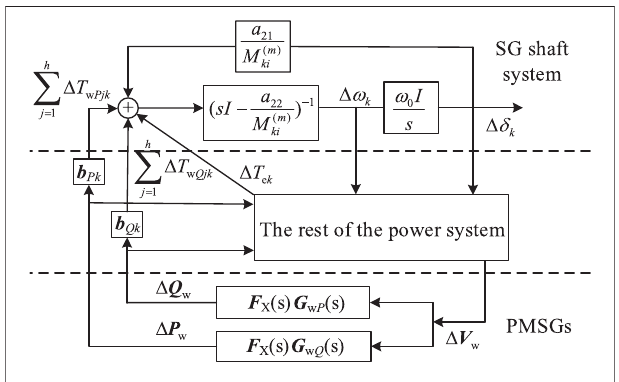
FIGURE 4 | Interconnected multimachine power system with multiple integrated PMSGs.